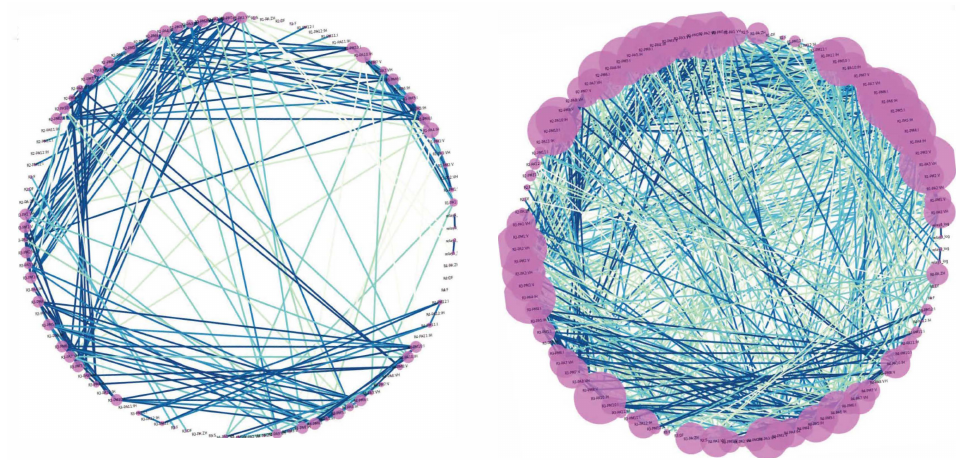
Figure 8. Line maintenance correlation network map with a coefficient of ( left ) 0.95 and greater and ( right ) 0.75 and